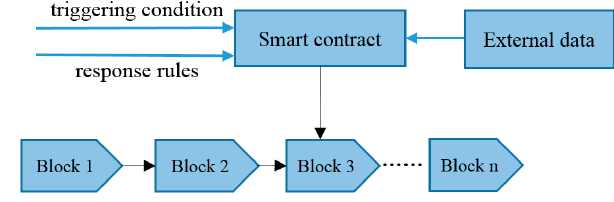
Figure 5. The response model of smart contract.